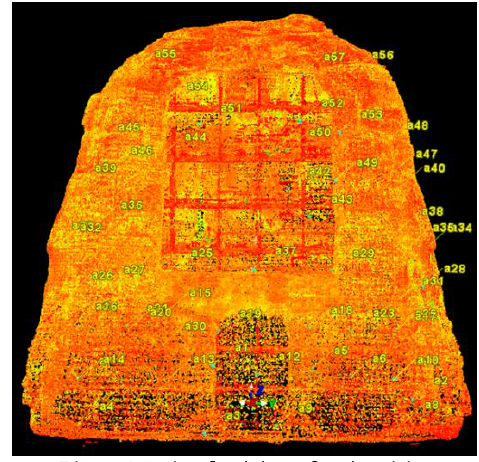
Figure 4. Point cloud data after denoising